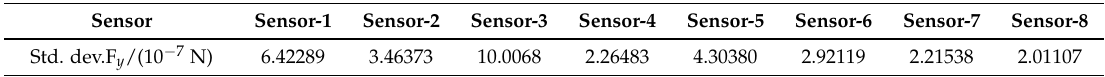
Table 6. Stand deviations of F y on each sensor.